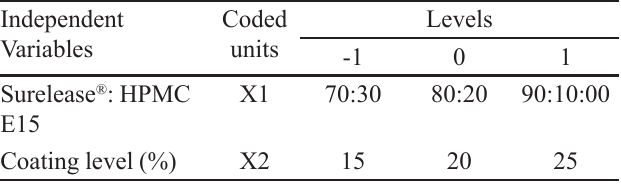
TABLE II - Factorial design data Independent